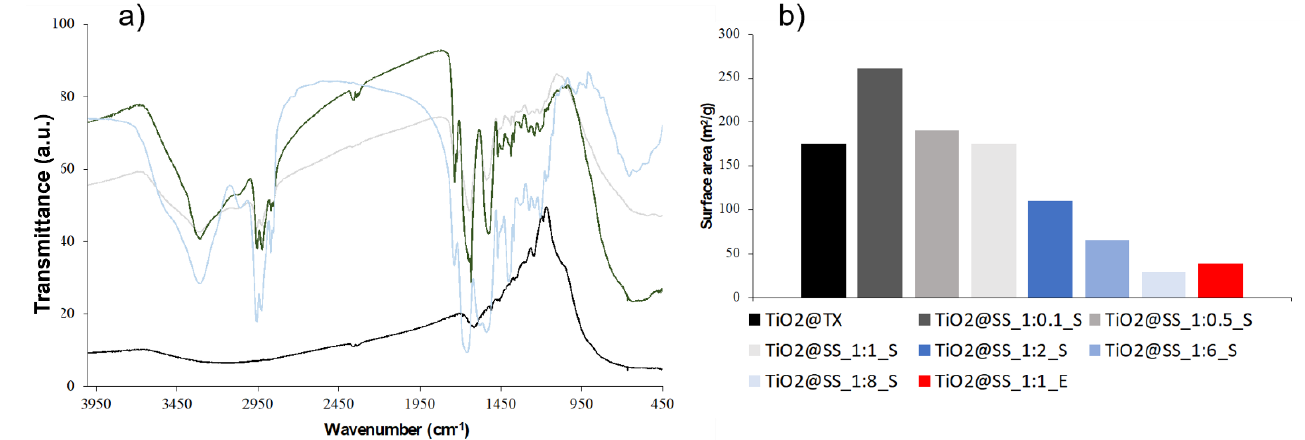
Figure 5. ( a ) FTIR spectra of TiO 2 @TX (black), SS (light blue), TiO 2 @SS_1:1_S (light gray), and TiO 2 /SS_1:1_E (dark green) samples and ( b ) specific surface area data (m 2 /g). The FTIR analysis on hybrid TiO 2 @SS_1:1_S and TiO 2 /SS_1:1_E samples allowed us